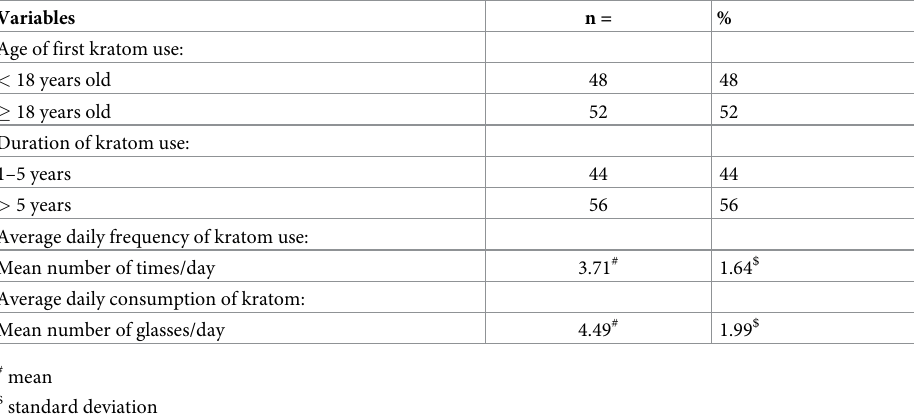
Table 2. Kratom use characteristics of the study’s kratom users. Variables